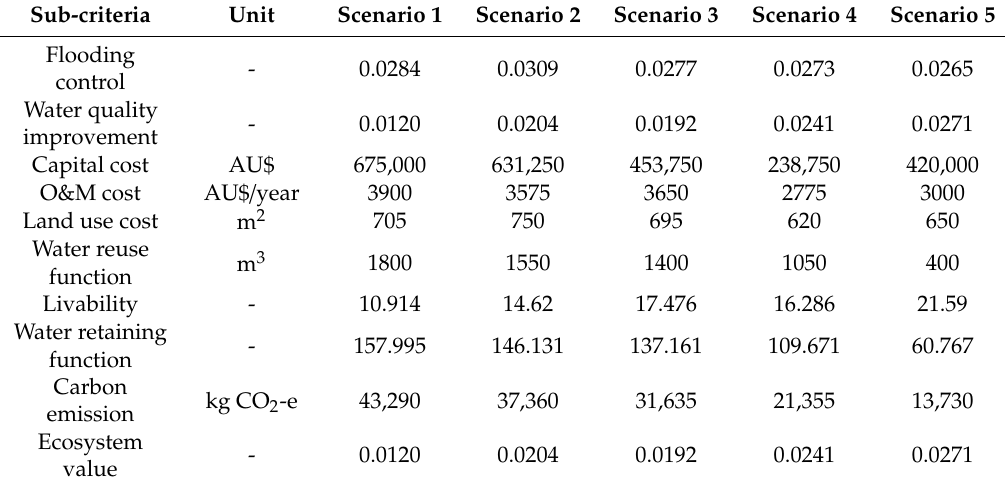
Table A12. The initial values of each scenario.